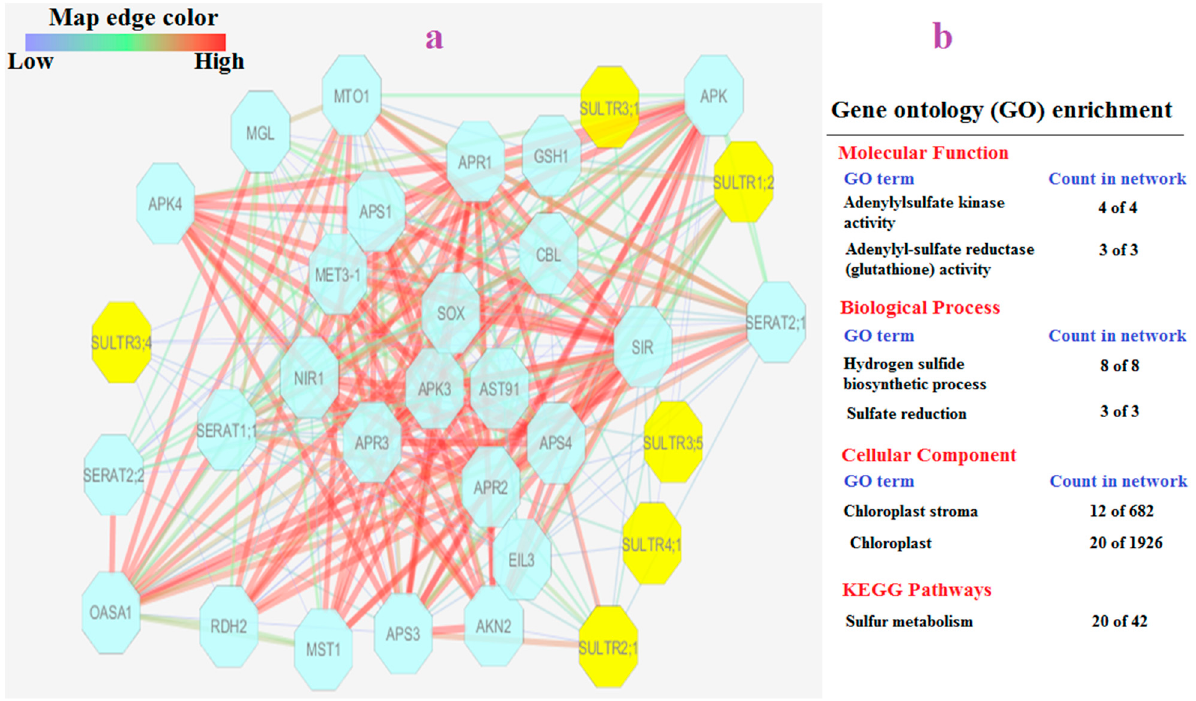
Figure 7. Interaction network of SULTR family members ( a ), and list of significant GO terms (FDR < 0.01) of nodes presented in network ( b ). Abbreviations: SERAT (serine O-acetyltransferase); APS (adenosine 5 ′ -phosphosulfate); APR (adenosine 5 ′ -phosphosulfate reductase); and APK (adeno- sine-5 ′ -phosphosulfate kinase).